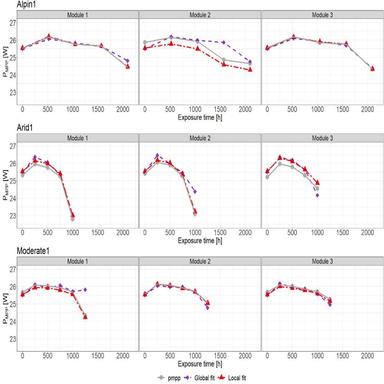
Fitted values for PMPP from the functional regression model of the UV-F (three modules for each ageing action).